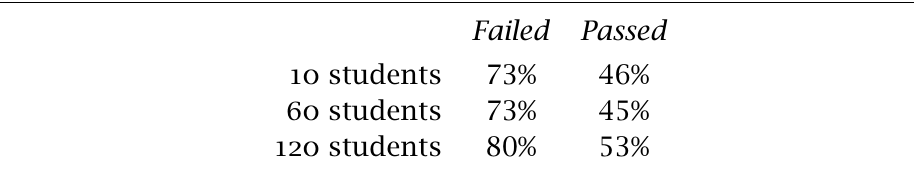
Percentages of positive answers by question and cardinality for